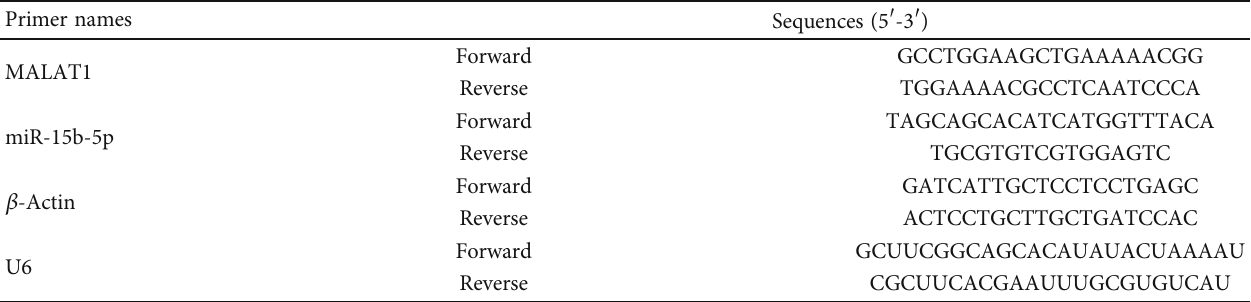
Table 2: qRT-PCR